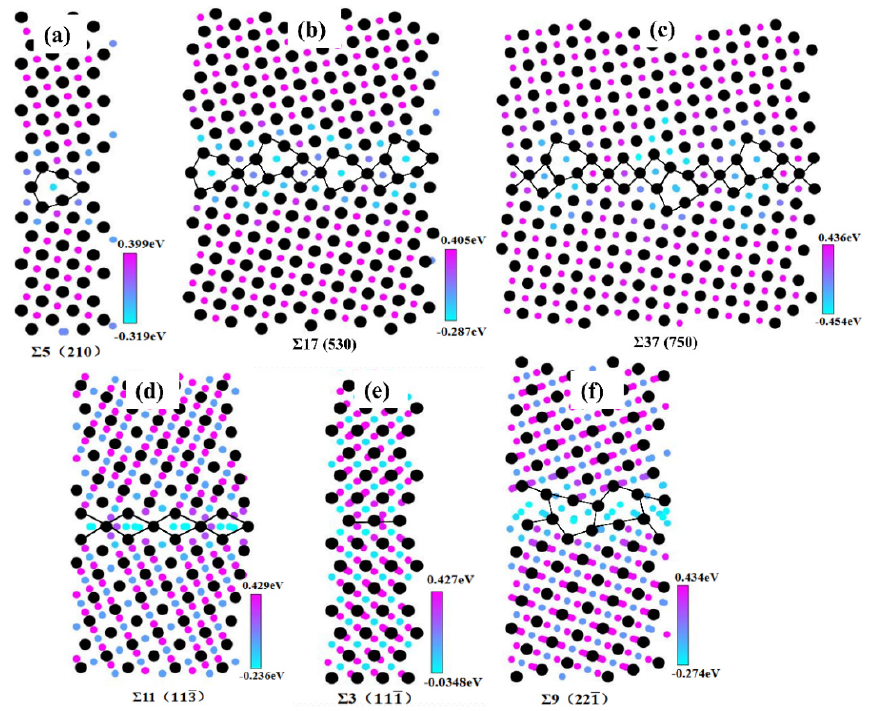
(cid:11) (cid:10) 110